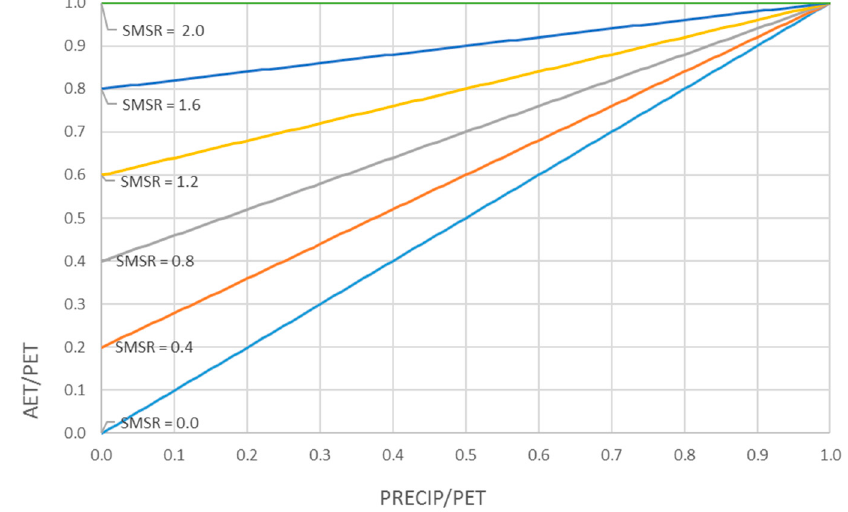
Figure 5. Soil moisture storage ratio/Excess moisture ratio.